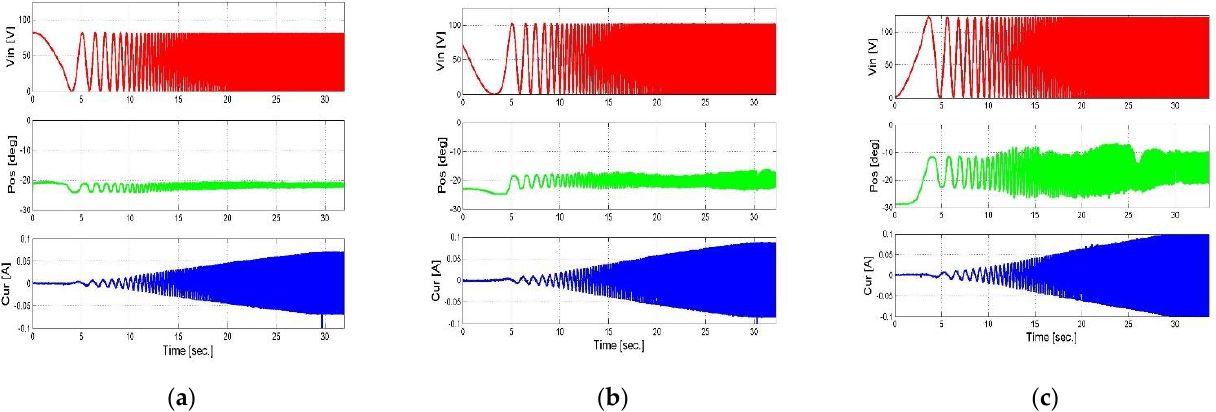
Figure 10. Measurement of output angle and current as results of the chirp input signal when the first load is applied. ( a ) Vin = 80 V, ( b ) Vin = 100 V, and ( c ) Vin = 120 V.